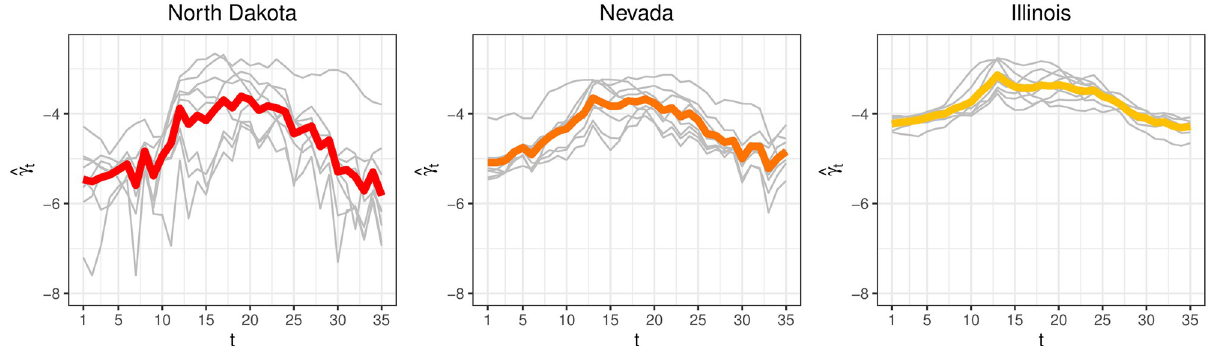
captures the typical profile of seasonal flu specific to t